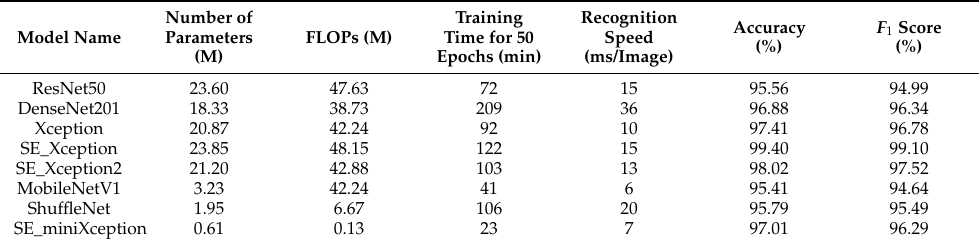
Table 1. Experimental results of compared models for ATLDD